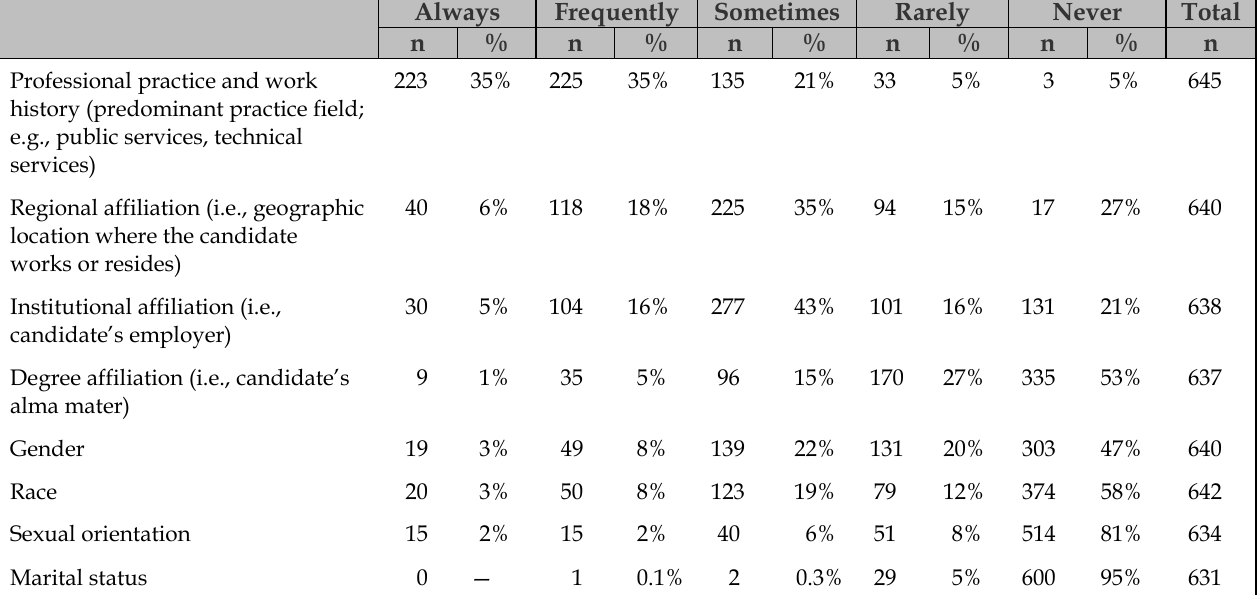
Table 2 Frequency of consideration of candidates’ professional and personal characteristics Always Frequently Sometimes